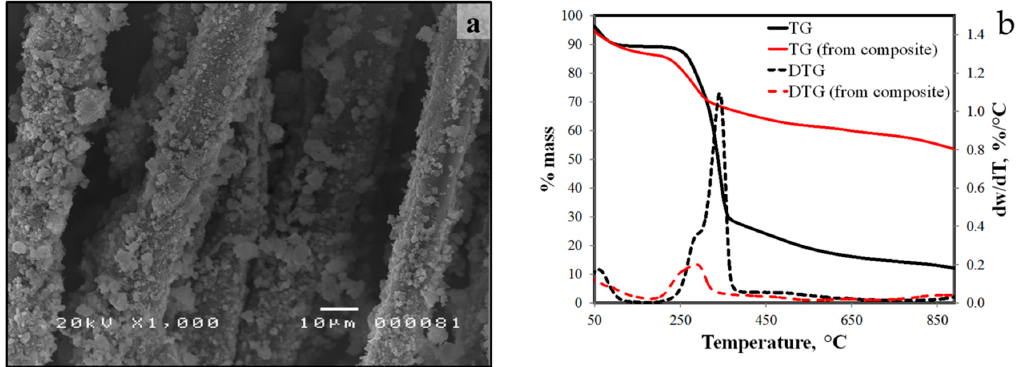
Figure 14. SEM image ( a ) and thermogram of untreated abaca fibers and treated abaca fibers ( b ) from the geopolymer composite.